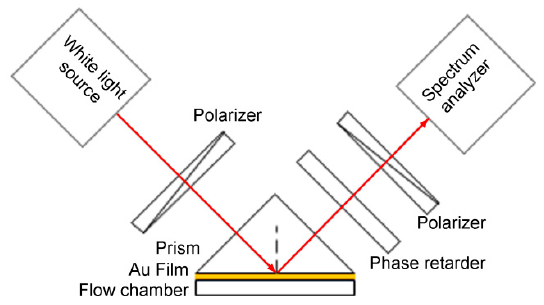
Figure 3. Ellipsometry scheme for SPR phase interrogation (Adapted from [40]).